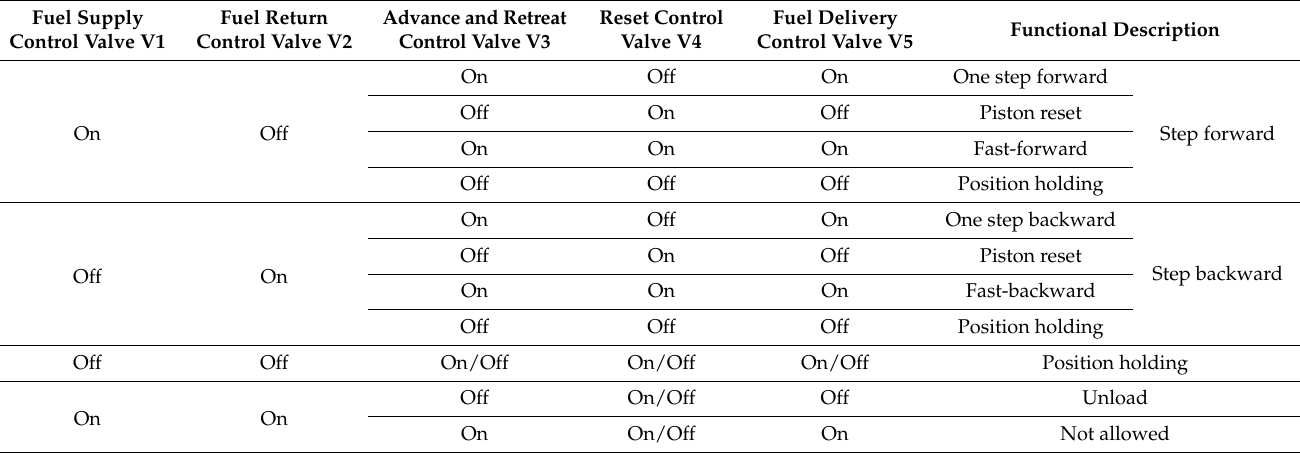
On/Off On Not allowed “Step Forward”: open the fuel supply control valve V1 and close the fuel return control valve V2. The stepper drive is in the step forward mode. At the same time, if the advance and retreat control valve V3 and the fuel delivery control valve V5 are open and the reset control valve V4 is kept closed, the system pressure encourages the fluid to enter the non-spring cavity of the step forward cylinder. The piston in the step forward cylinders starts to move from the bottom. When it moves to the limit position, the